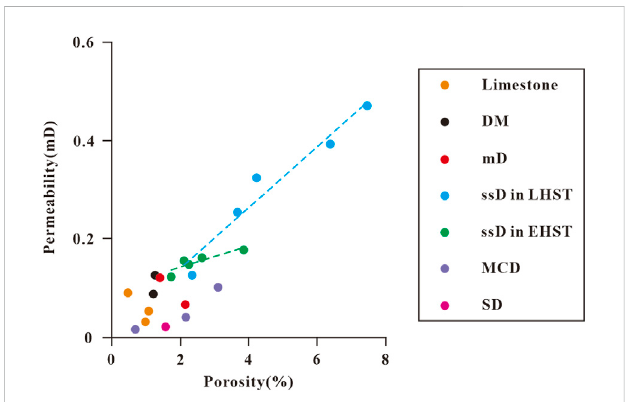
FIGURE 12 Crossplot of porosity and permeability in the upper changping formation, Dingjiatan area, North China